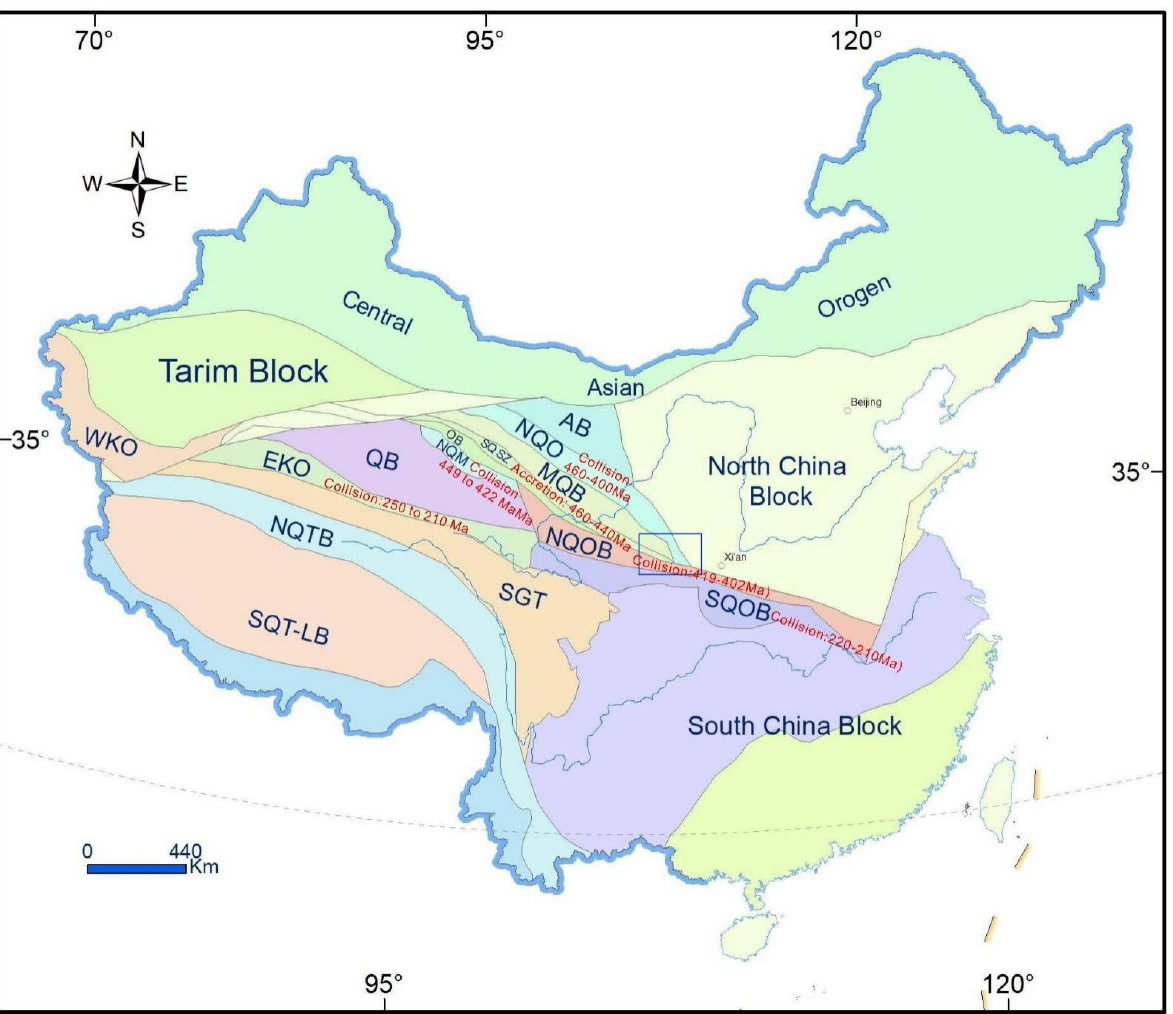
Figure 1. A simplified tectonic division map of China modified after Wang et al. (2013) [6] and components of the Central China Orogenic System and its adjacent blocks, marking the location of the study area. Abbreviations: NQO: North Qilian Orogen (collision: 460–400 Ma [3]); SQSZ: South Qilian Suture Zone (accretion: 460–440 Ma [7]); NQM: North Qaidam UHPM (collision: 449–422 Ma [8]); NQOB: North Qinling Orogenic Belt (collision: 419–402 Ma [9]); SQOB: South Qinling Orogenic Belt (collision: 220–210 Ma [4]); EKO: East Kunlun Orogen (collision: 250–210 Ma [10]); WKO: West Kunlun Orogen. AB: Alxa Block; MQB: Middle Qilian Block; QB: Qaidam Block; TB: Tarim Block; OB: Oulongbuluke Block; SGT: Songpan-Ganzi Terrane; SQT-LB: South Qiangtang and Lashan Blocks; NQTB: North Qiangtang